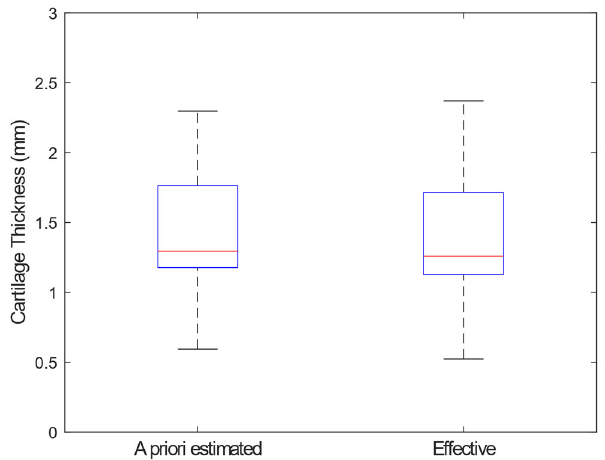
Figure 2. Box plot of the estimated and effective thickness